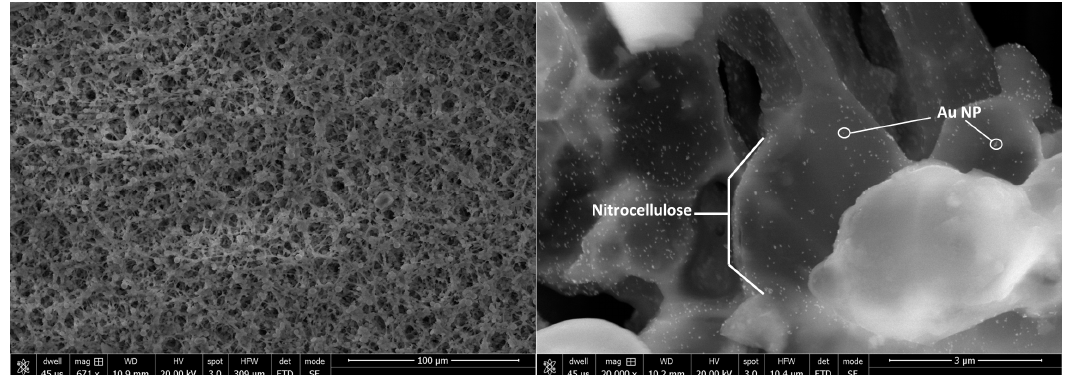
Figure 3. Scanning electron microscopy (SEM) of gold nanoparticles bound to the test line. At 671× magnification (left), the nominal 10-µm pore structure of the nitrocellulose membrane is evident; at 20,000× magnification (right), 40-nm gold nanoparticles are clearly visible. Courtesy of Kevin Nichols, Intellectual Ventures Laboratory.